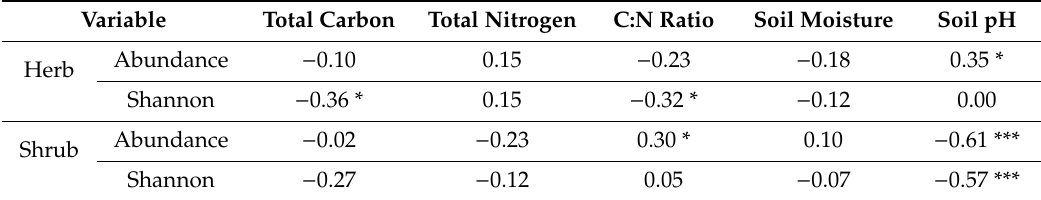
Table 2. Pearson’s correlation between the soil properties and the abundance and diversity of herbs and shrubs. Significance of main e ff ects are shown as: *, significant at p < 0.05; and ***, significant at p < 0.001.